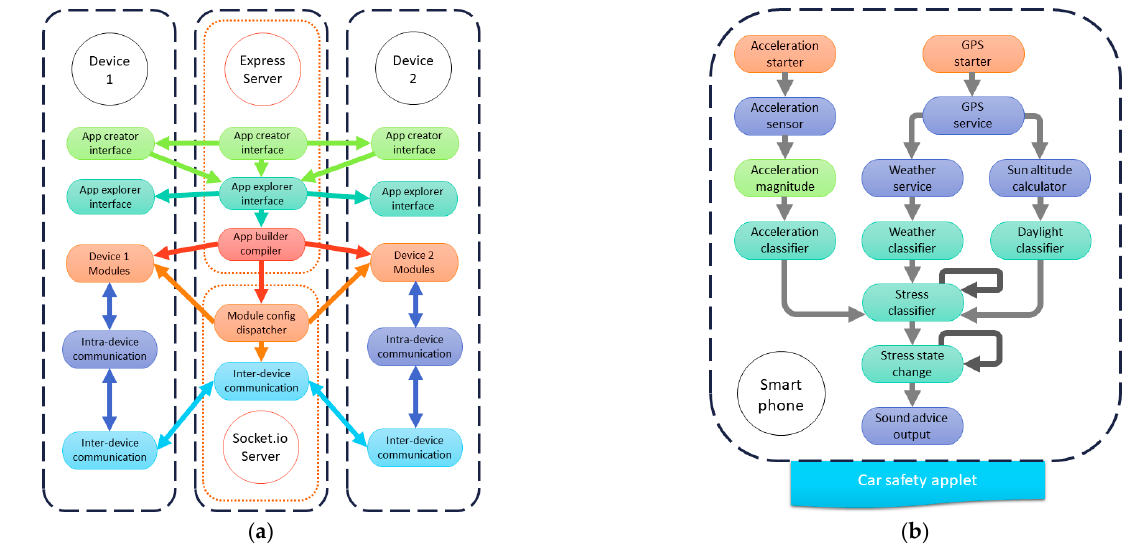
Figure 3. ( a ) The platform’s core components and their interaction when two devices are connected. ( b ) Oriented graph of the data flow for a standalone mobile application for safe car driving (Con- fiDrive) that was created and explored using the DEMOS platform.